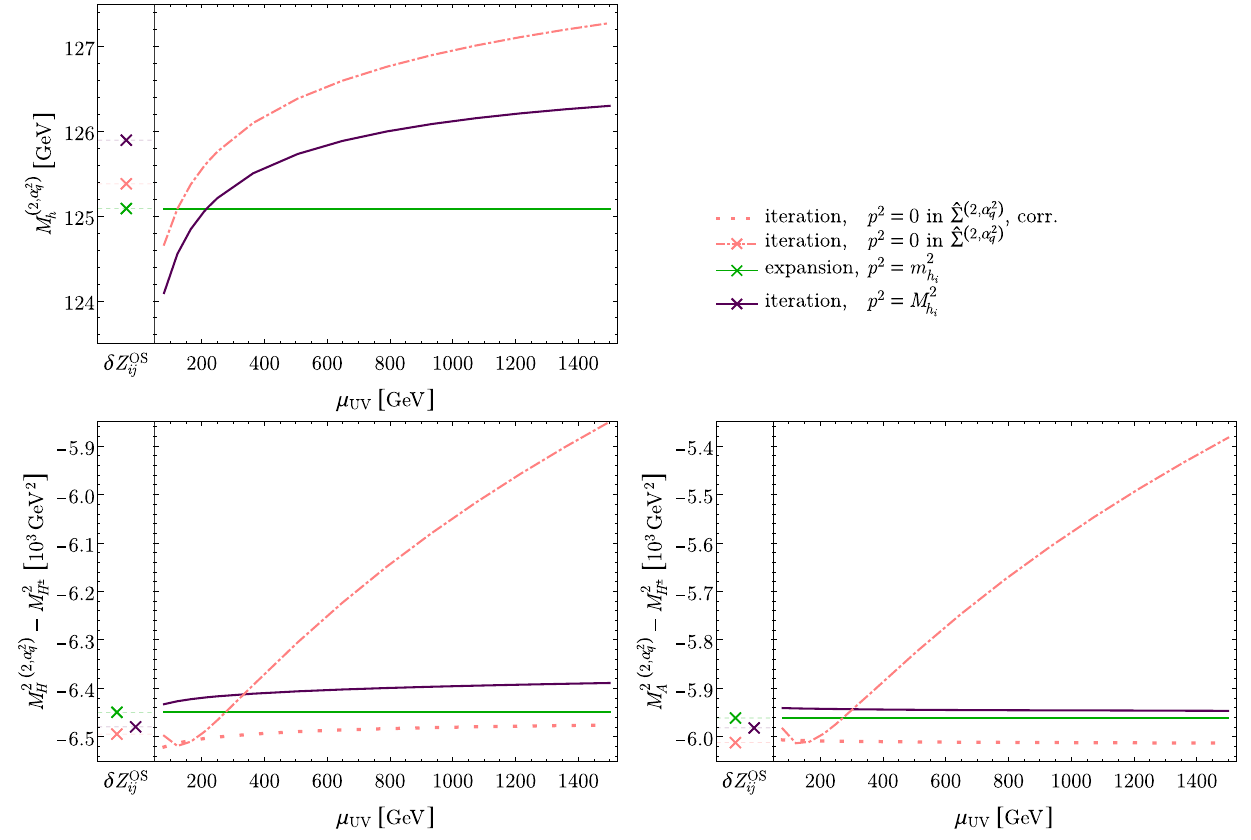
Fig. 6 Dependence on the field-counterterms in mass predictions of order α 2 q . The solid green line is derived with the expansion at strict order, the purple one, with an iterative pole search. The 2L self-energies are included in the effective potential approximation for the dot-dashed pink